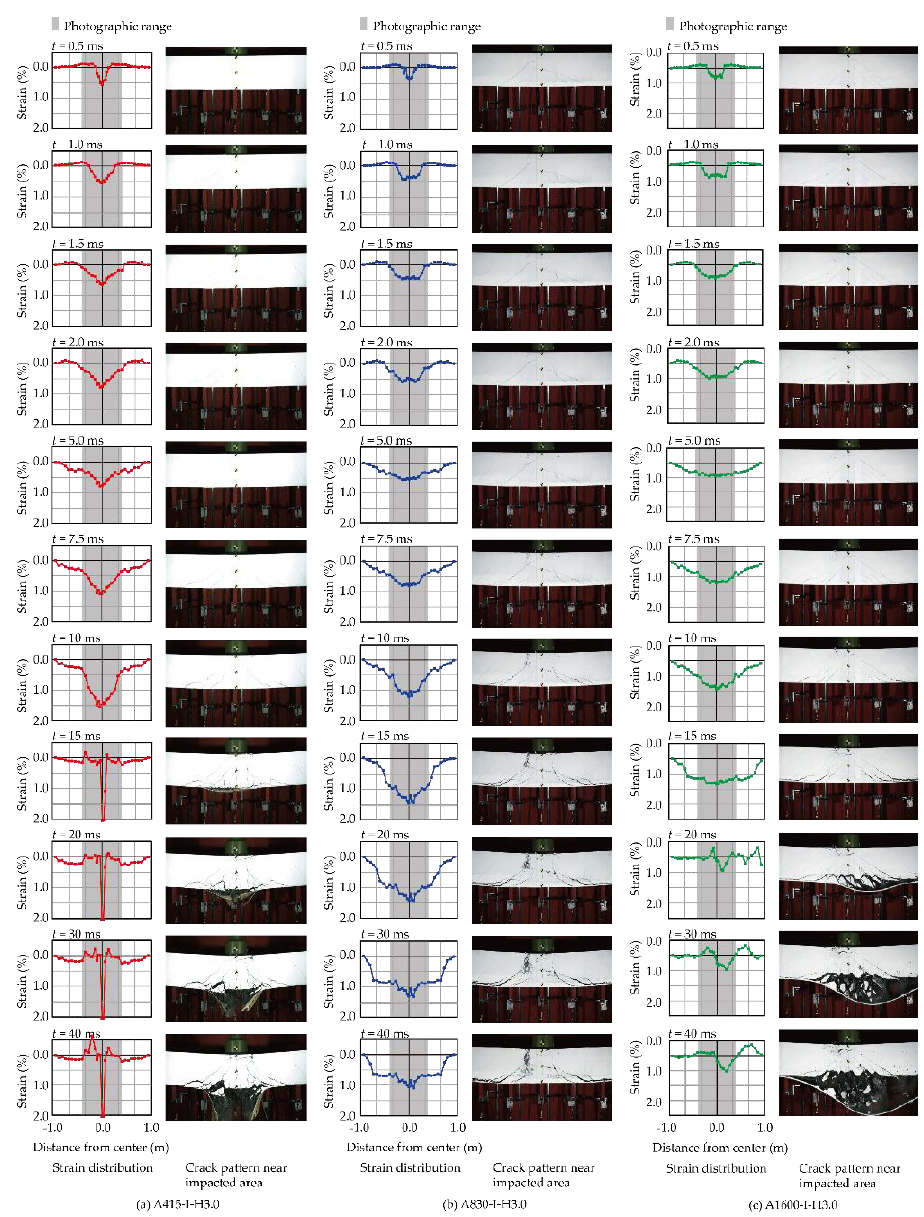
Figure 14. Temporal transition of the strain distribution of the AFRP material and crack patterns near the loading point for drop height H = 3.0 m.